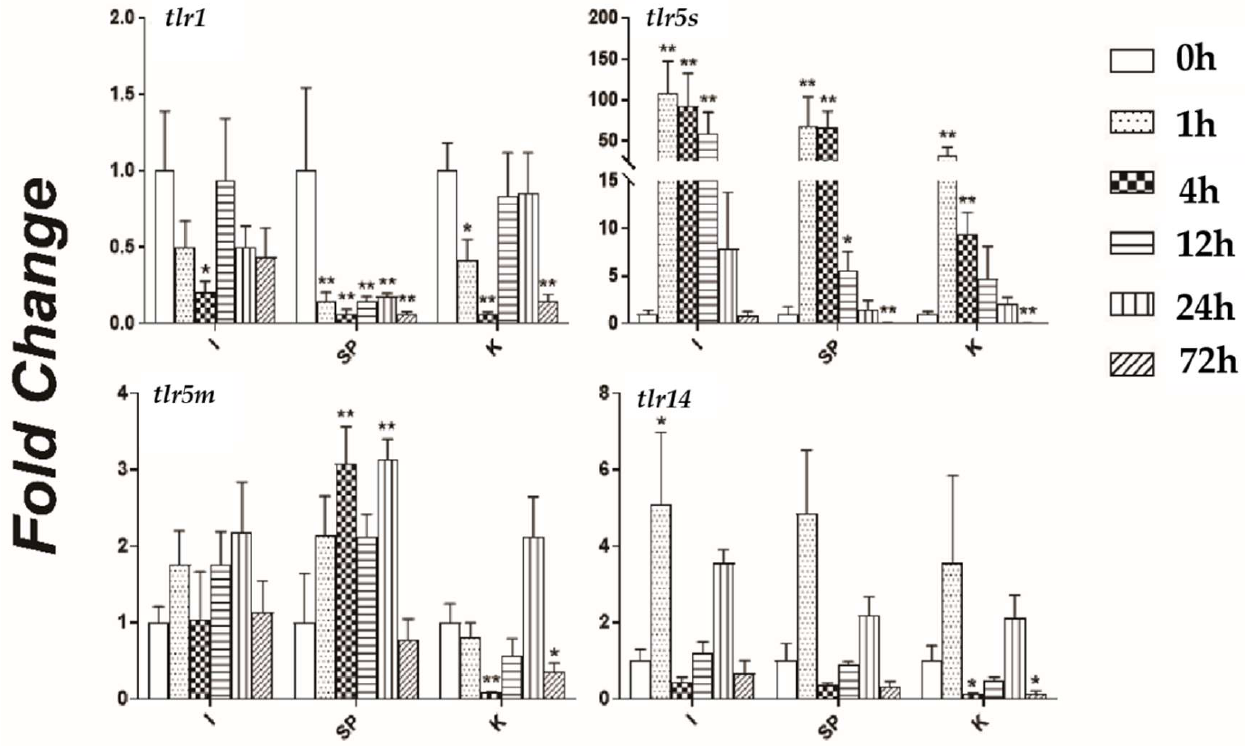
Figure 9. The expression patterns of the Toll-like receptor (TLR) genes tlr1 , tlr5s , tlr5m , and tlr14 in swamp eel tissues at different timepoints (0, 1, 4, 12, 24, and 72 h) after A. veronii challenge. The expression levels of the four TLR genes in intestine (I), spleen (SP), and kidney (K) were determined by quantitative real-time reverse transcription PCR. Asterisks (*) mark the significant differences between the experimental and control groups ( p < 0.05). Asterisks (**) mark an extremely distinct differences between the experimental and control groups ( p < 0.01). Error bars indicate the standard error ( n = 5).